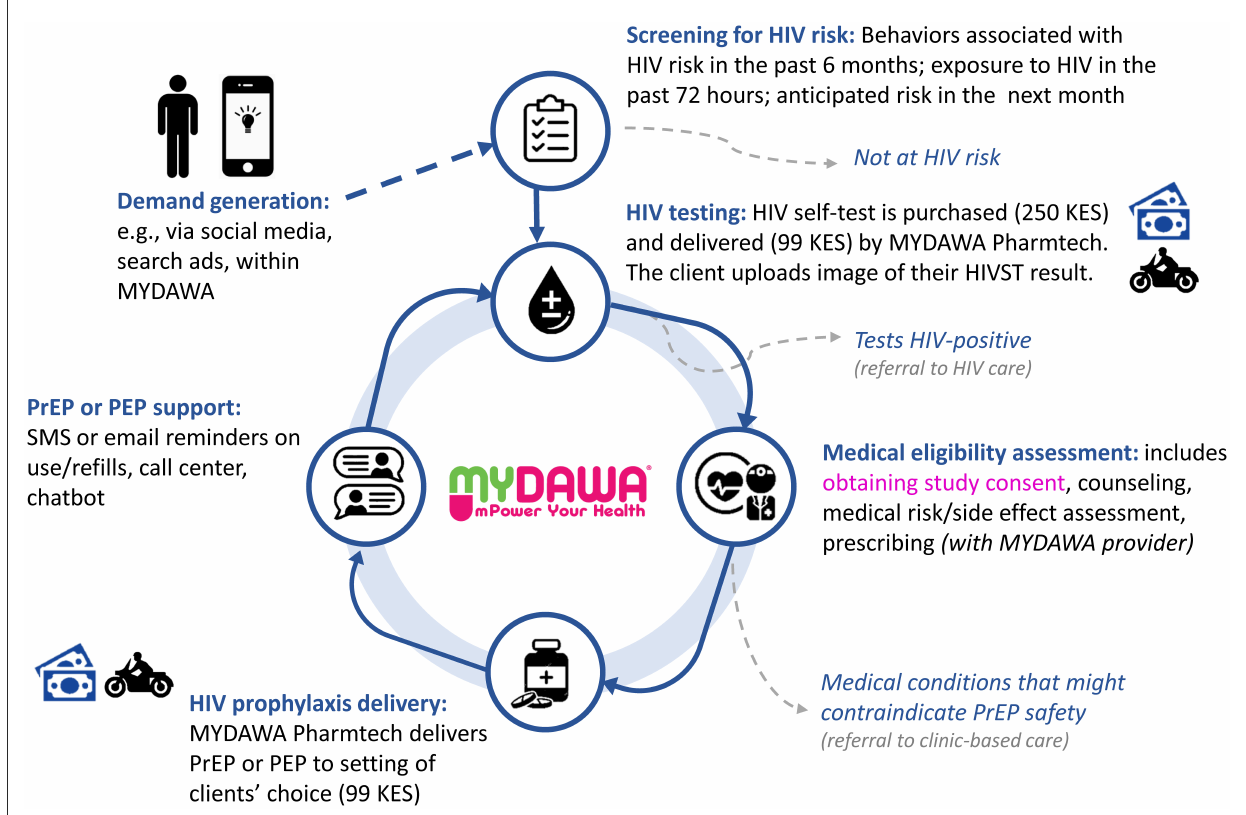
FIGURE1 The proposed care pathway for online pharmacy PrEP or PEP service delivery via